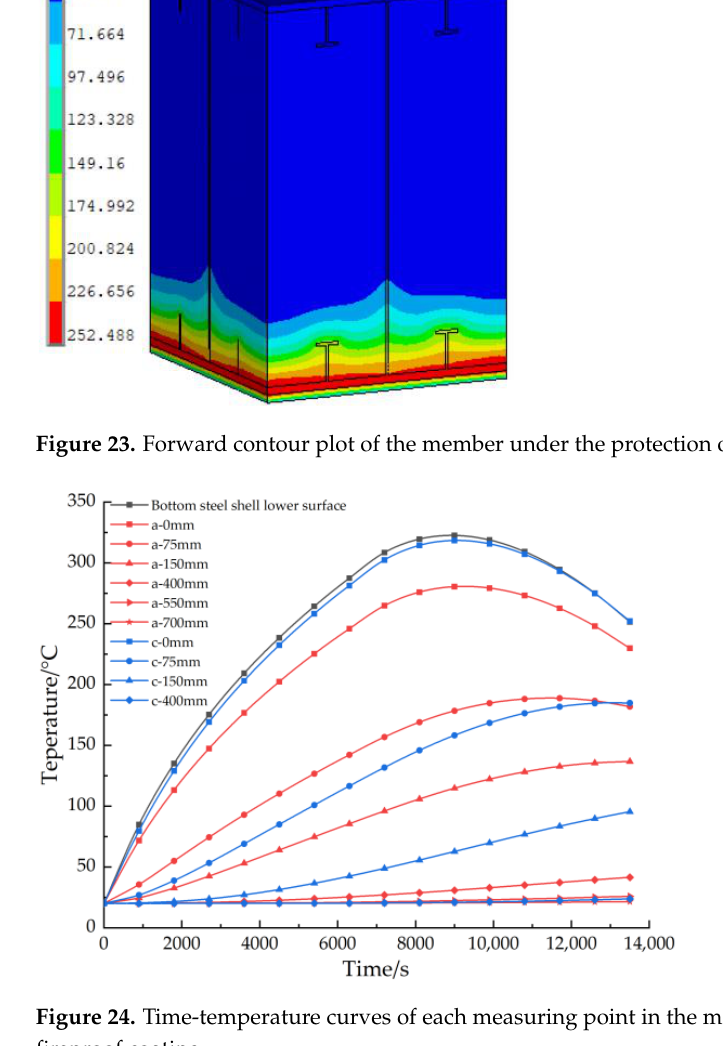
Figure 24. Time-temperature curves of each measuring point in the member under the protection of fireproof